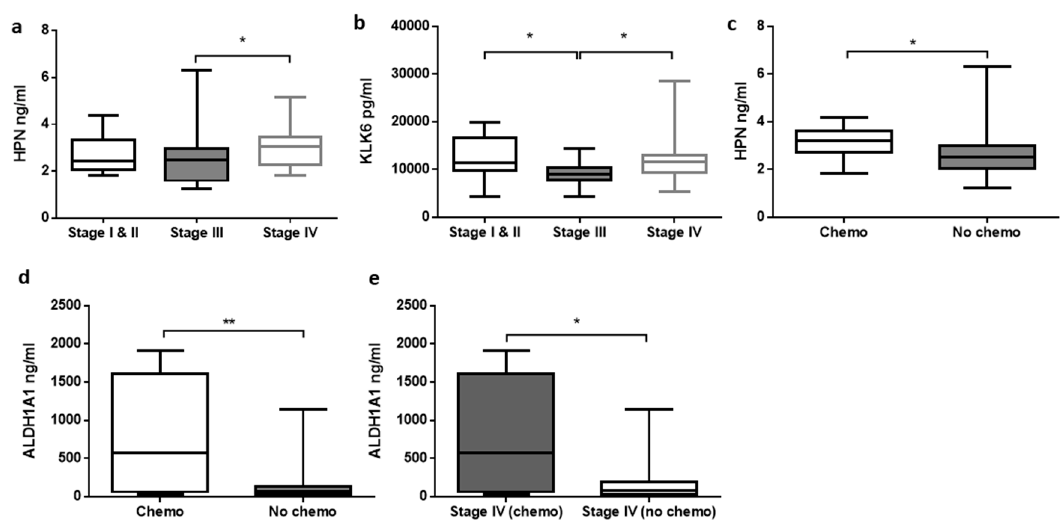
Figure 2. Comparisons of concentrations of biomarkers in serum based on the clinicopathological features: (1) Number staging: ( a) HPN stage III vs. IV ( p = 0.034); ( b ) KLK6 stage I & II vs. III ( p = 0.031) and stage III vs. IV ( p = 0.023); (2) Chemotherapy status: ( c ) HPN chemotherapy vs. no chemotherapy ( p = 0.036); ( d ) ALDH1A1 chemotherapy vs. no chemotherapy ( p = 0.008); (3) Chemotherapy status in stage IV CRC patients: ( e ) ALDH1A1 stage IV chemotherapy vs. no chemotherapy ( p = 0.048). Results were expressed as median with the lowest (minimum) and largest (maximum) concentrations, and standard error of means. Boxplot with * signified p < 0.05 and ** signified p < 0.01 among different models.